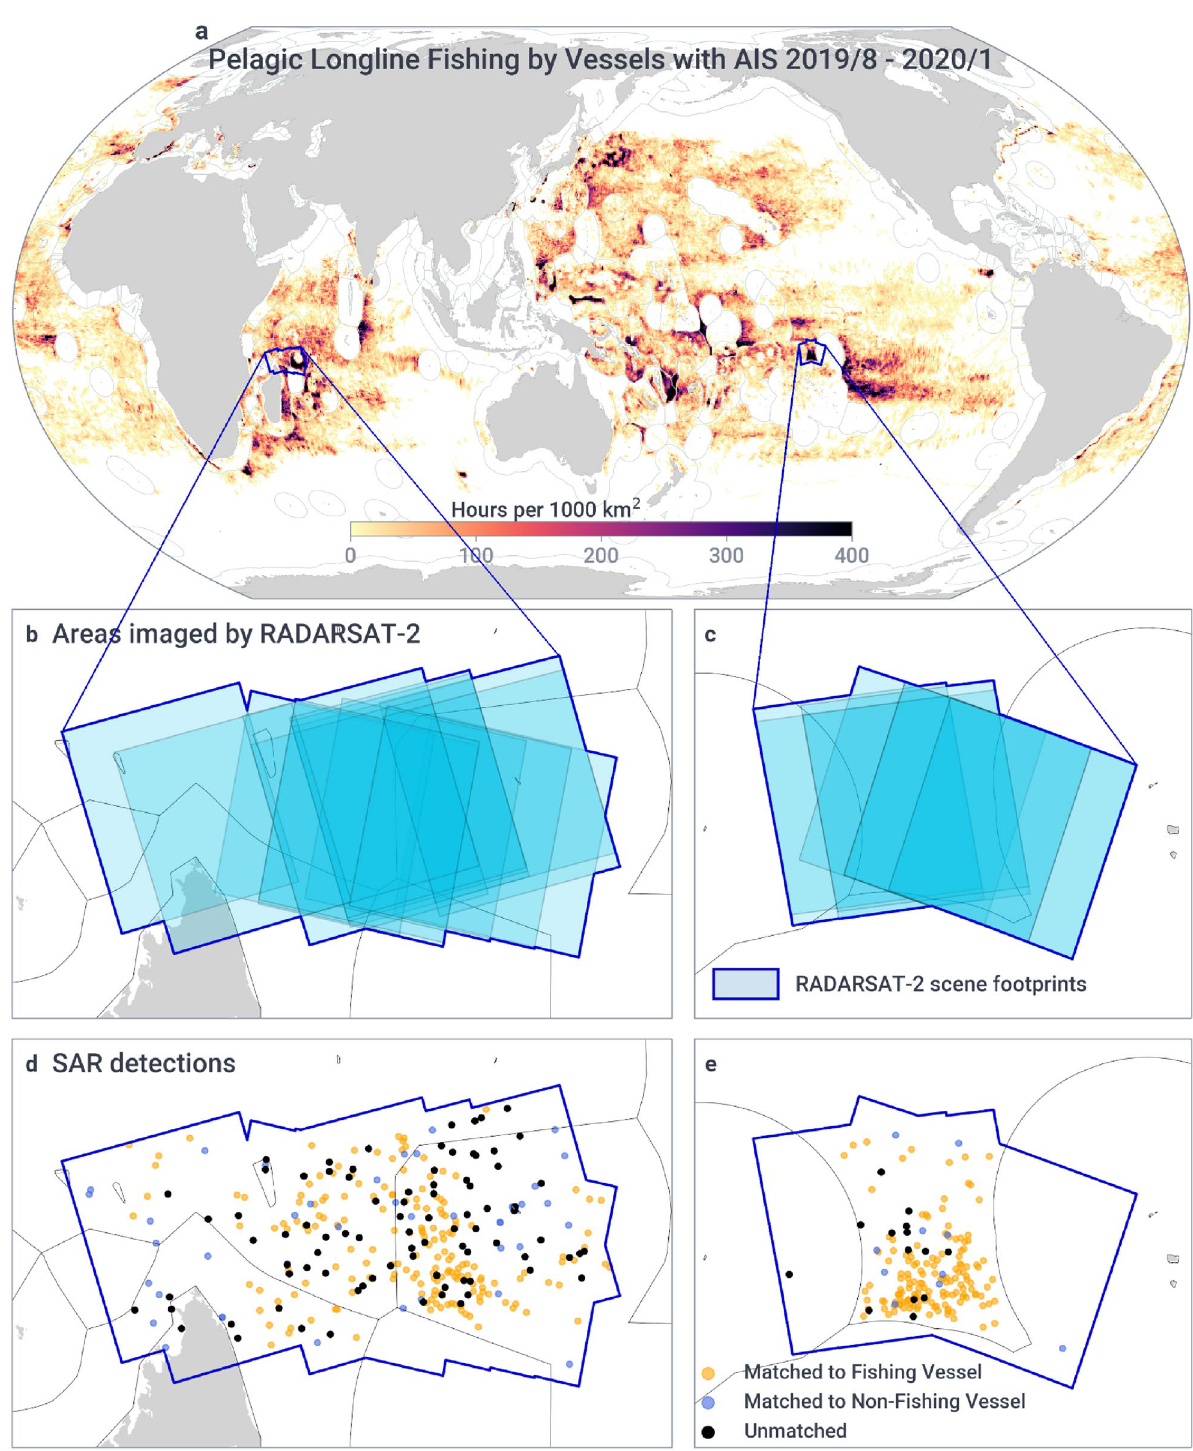
Figure 1. SAR detections were collected in two regions of intense longline fishing. ( a ) Global pelagic longline activity during our study period (Pacific: Aug–Sep/2019, Indian: Oct/2019 to Jan/2020), measured in hours of fishing per 1000 km 2 . ( b ) 15 images were acquired over the Indian Ocean north of Madagascar, including parts of the exclusive economic zones of Mauritius, Seychelles, and Madagascar. ( c ) Nine images in the Pacific focused on the high seas between Kiribati and French Polynesia, including parts of these countries’ exclusive economic zones. ( d , e ) Detections of vessels from SAR imagery, matched and unmatched to vessels broadcasting AIS. Maps generated using Python 3.9.6 and PySeas library (https:// github. com/ Globa lFish ingWa tch/